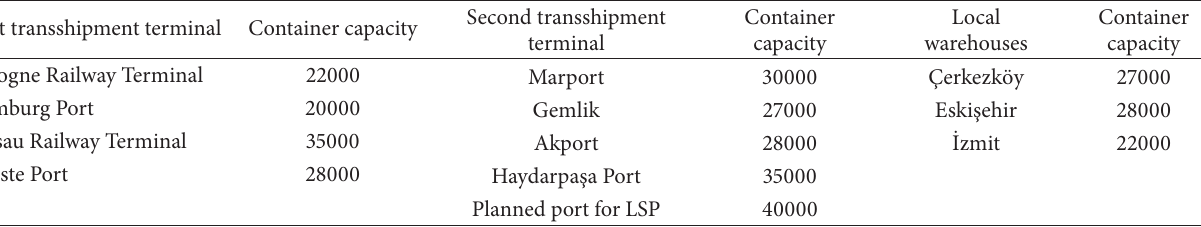
Table 18: Container capacities of each